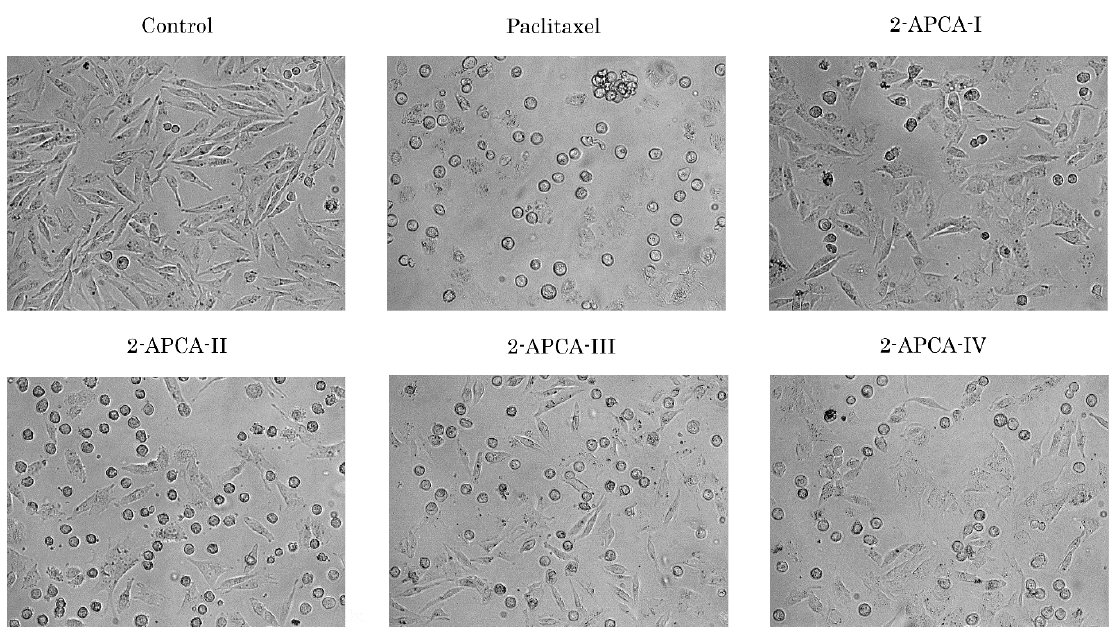
Figure 2. The 2-APCAs induce the changes in morphology of cancer cells. Morphological changes in IM-resistant gastrointestinal stromal tumor (GIST T-1R) cells treated with solvent (DMSO) (negative control), 2-APCAs, and paclitaxel (positive control). Cells were treated with 10 µ M of 2-APCAs (I-IV), or 0.1 µ M paclitaxel for 24 h and further subjected to the light microscopy (10 × magnification).